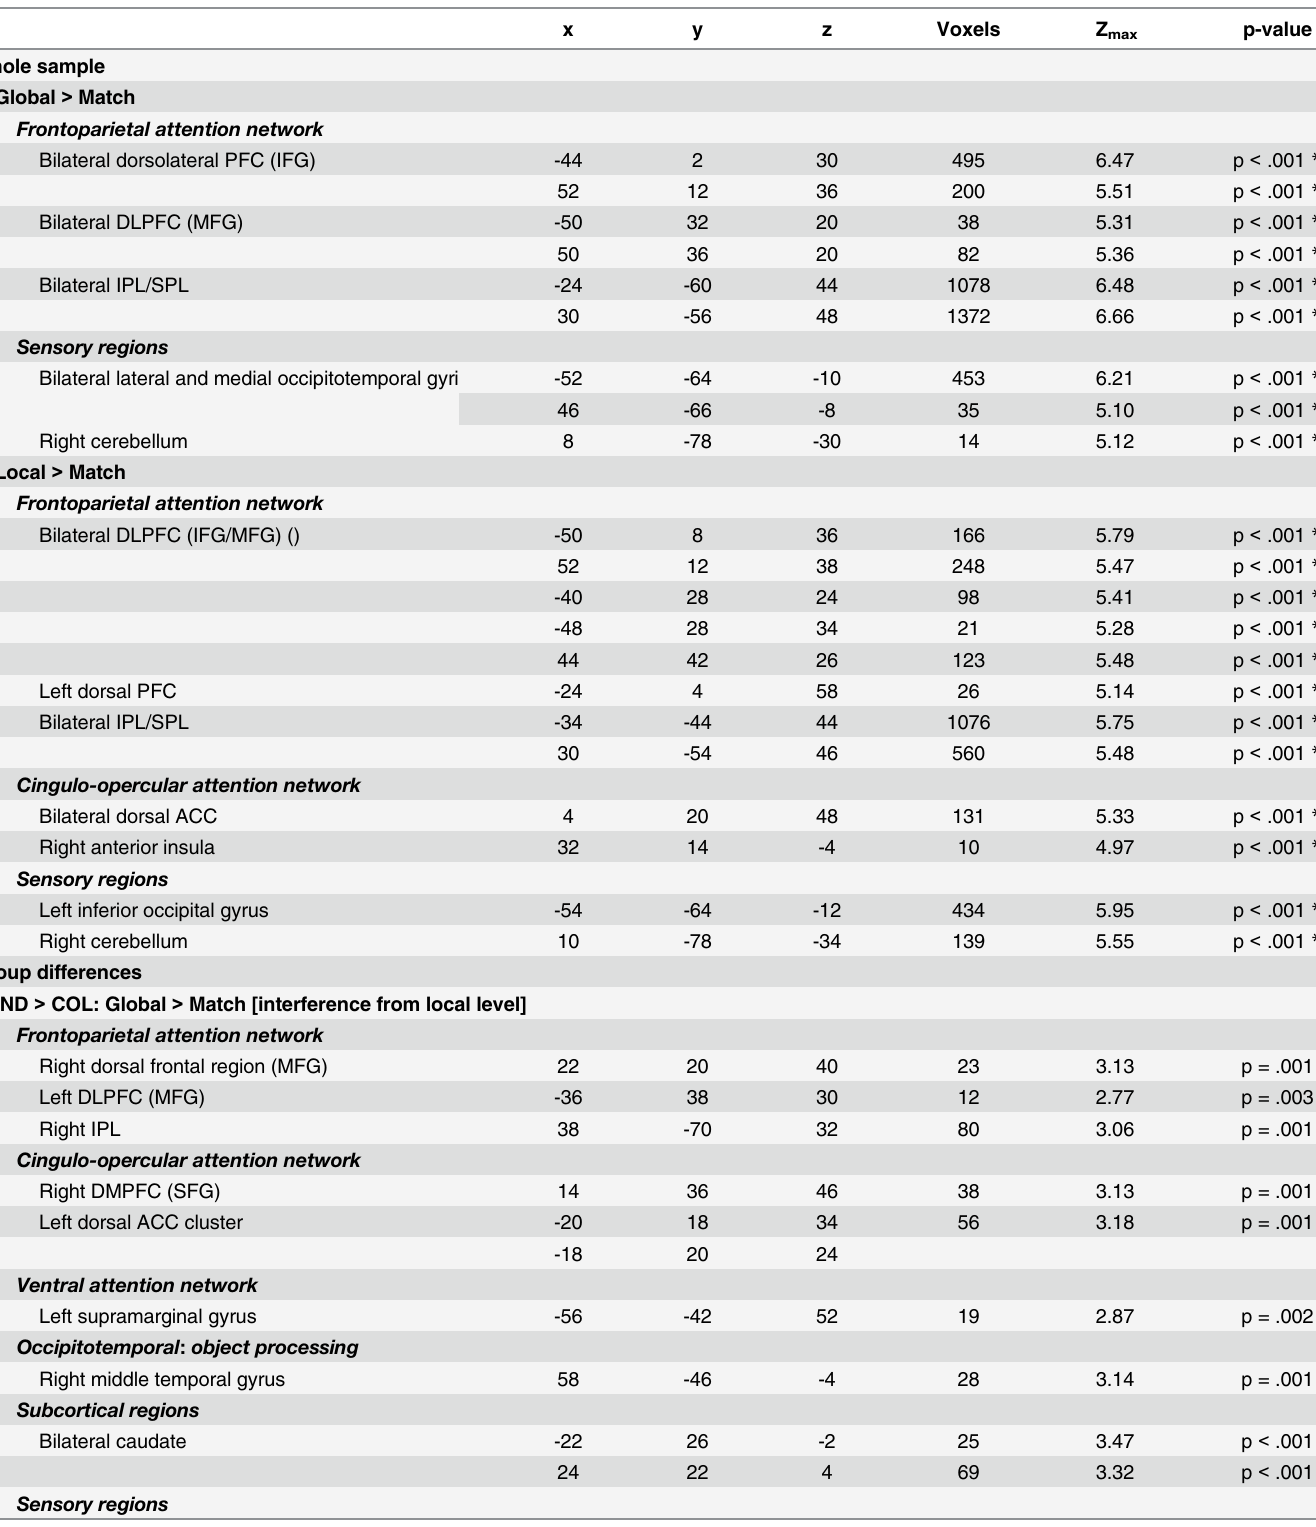
Table 3. Global/Local incongruent vs match congruent baseline condition for whole sample (n = 30) and two-sample comparisons. x y z Voxels Z max p-value Whole